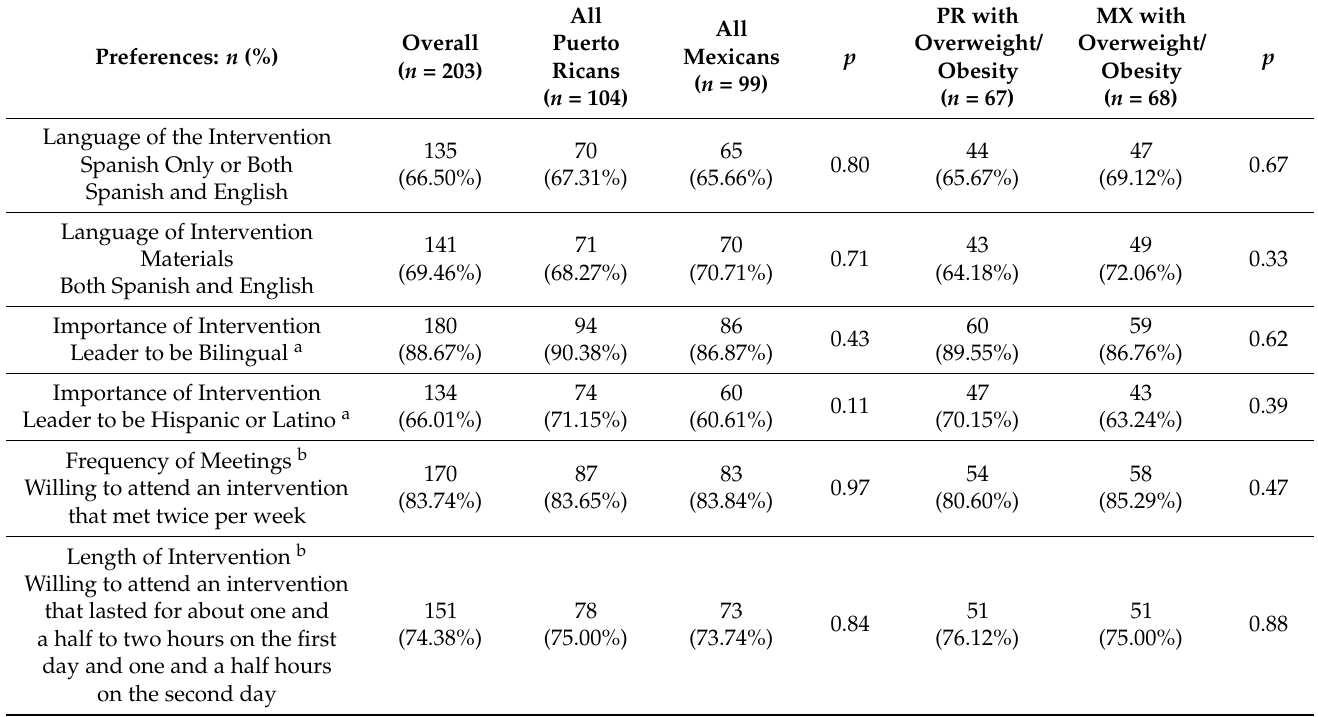
Table 1. Preferences for Language, Hispanic/Latino Background, Length, and Frequency of the Intervention among All Participants and among Participants with Overweight or